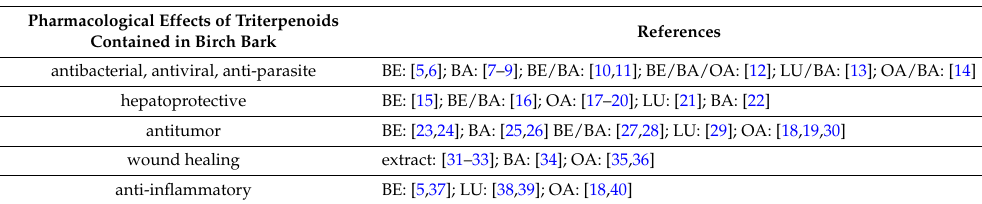
Table 1. Pharmacological effects of triterpenoids obtained from bark of birch. BE: betulin, BA: betulinic acid, OA: oleanolic acid, LU: